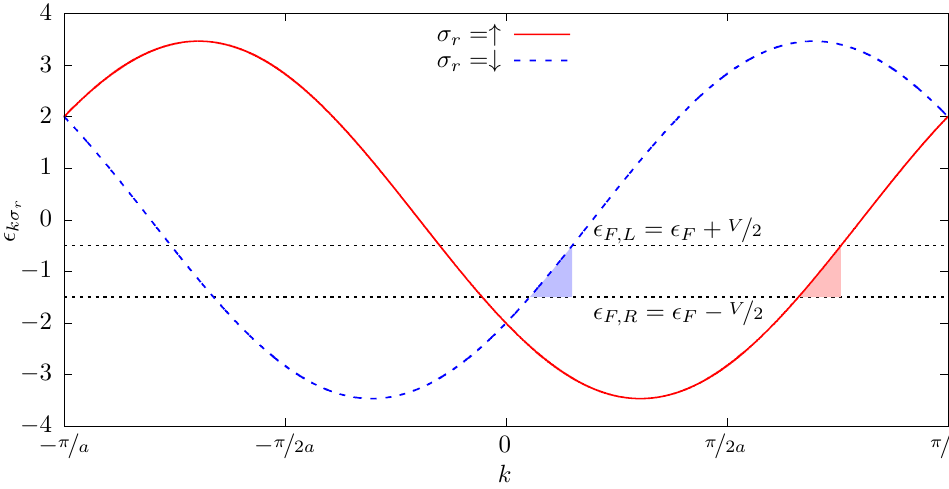
Figure 2. Dispersion relation (cid:101) k σ as a function of k and spin σ r . The SOC intensities are taken to be r α = β = 1 t . The colored shadows illustrate, for each spin and (cid:101) F , R < (cid:101) < (cid:101) F , L , the electronic states that participate in the